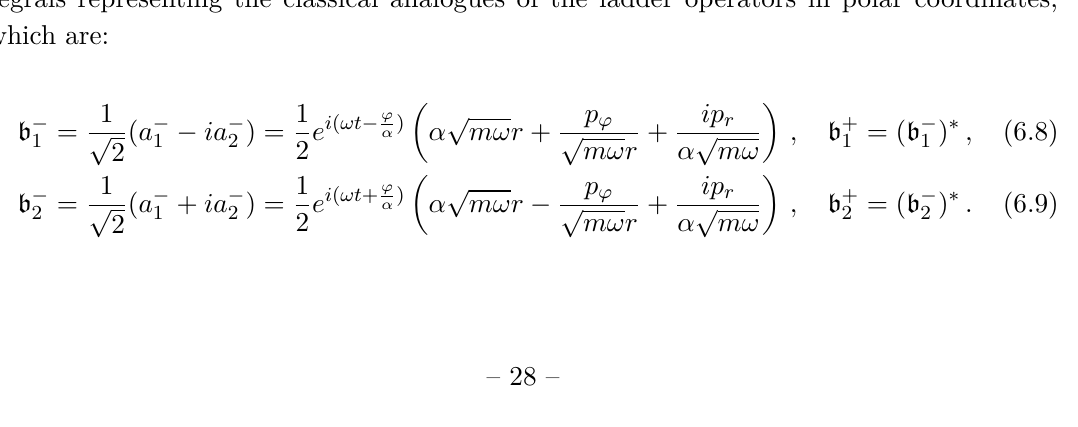
and maxima r depends on − + = k ( q mod 2 + 1) max / min